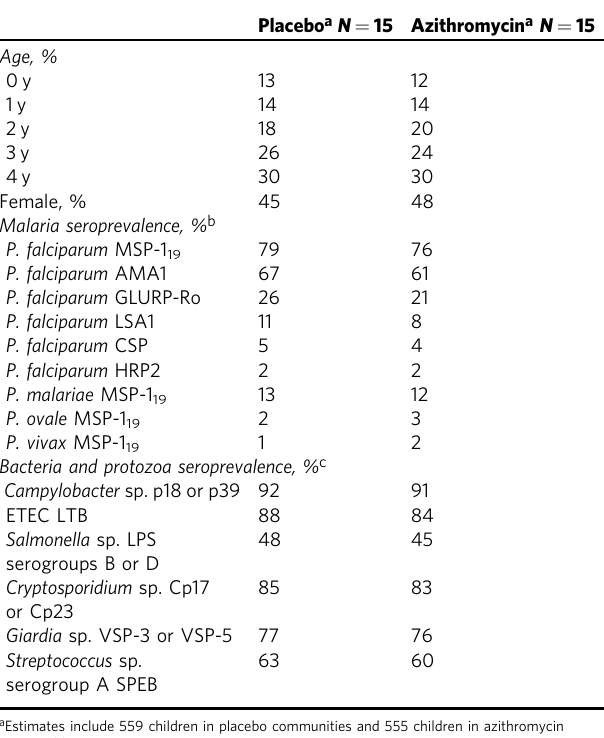
Table 1 Baseline study group